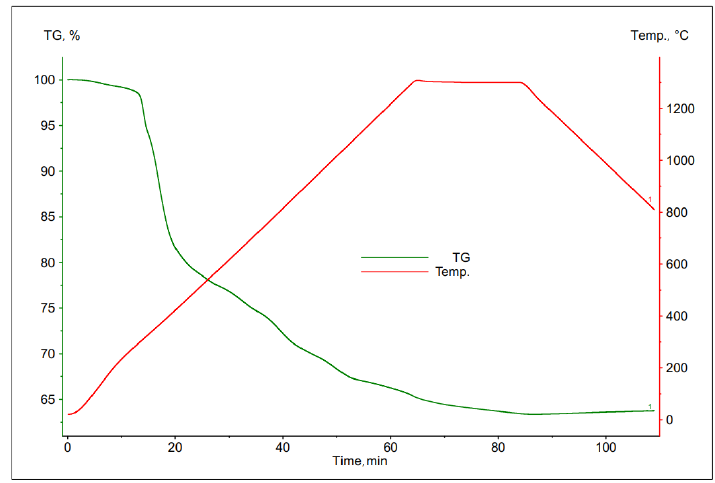
Figure 6. Change in mass of a sample with grain size <1.6 mm during its heating.